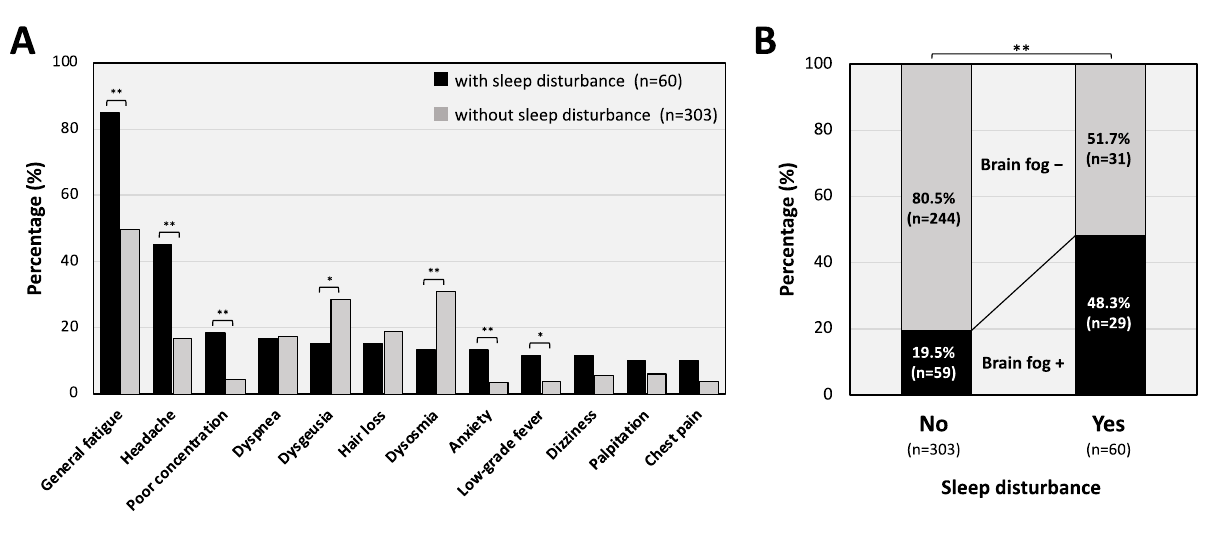
Figure 2. Major symptoms accompanying sleep disturbance in patients with long COVID. ( A ) Percentages of patients with major long COVID symptoms in long COVID patients with and those without, sleep disturbance. ( B ) Prevalence of brain fog symptoms in long COVID patients with, and those without, sleep disturbance. The χ 2 test was performed for each symptom between the groups and * p < 0.05 and ** p < 0.01 were considered as statistically significant. Sleep disturbance was further divided into four types of insomnia (Figure 3). Among